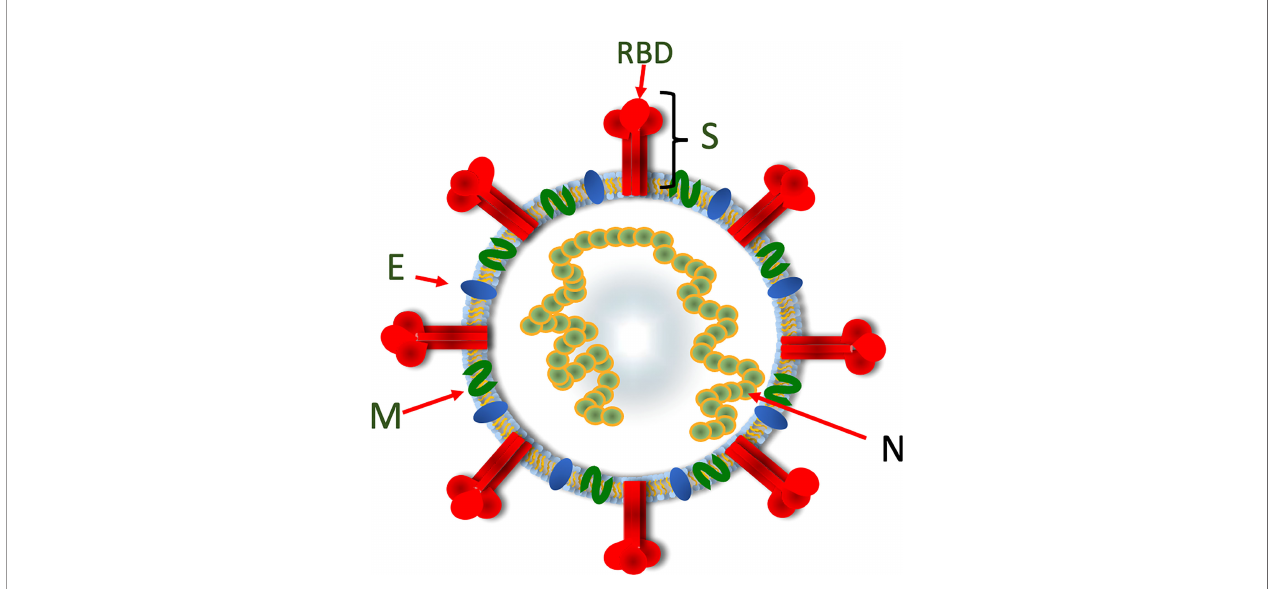
FIGURE 3 | A diagrammatic representation of SARS-CoV-2 showing the organisation of the viral structural proteins. The spike protein assembles into a trimeric structure with the RBD located at the top of the trimer. The spike trimer is embedded in a lipid bilayer containing the membrane and envelope proteins. The nucleoprotein binds the viral RNA and also serves to stabilize the base of the spike trimer. Spike, S; Receptor-binding domain, RBD; Membrane, M; Envelope, E; Nucleoprotein, N.